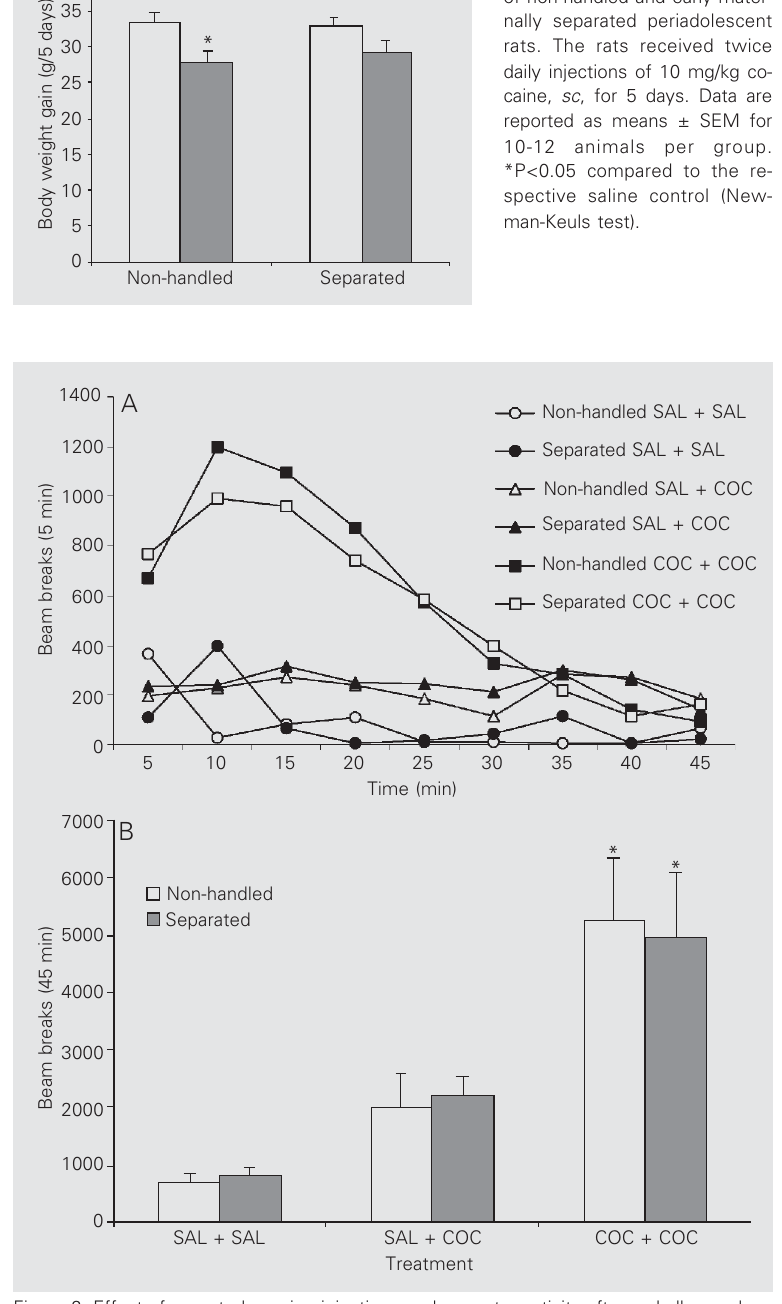
Figure 2. Effect of repeated cocaine injections on locomotor activity after a challenge dose of cocaine in non-handled and early maternally separated periadolescent rats. A challenge dose of 10 mg/kg cocaine ip was administered to animals pretreated with twice daily injections of 10 mg/kg cocaine sc for 5 days. Data are reported as means ± SEM for 6-8 animals per group of cumulative photocell counts during 5-min (A) and 45-min intervals (B). *P<0.05 compared to the respective SAL + SAL or SAL + COC control (Newman-Keuls test). SAL = saline, COC =